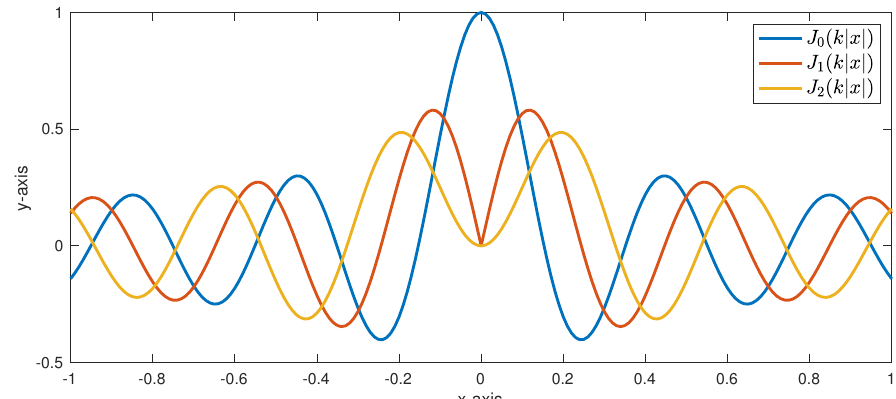
Figure 2. The 1D plot of J n ( k | x | ) for k = 2 π /0.4, n = 1,2,3.